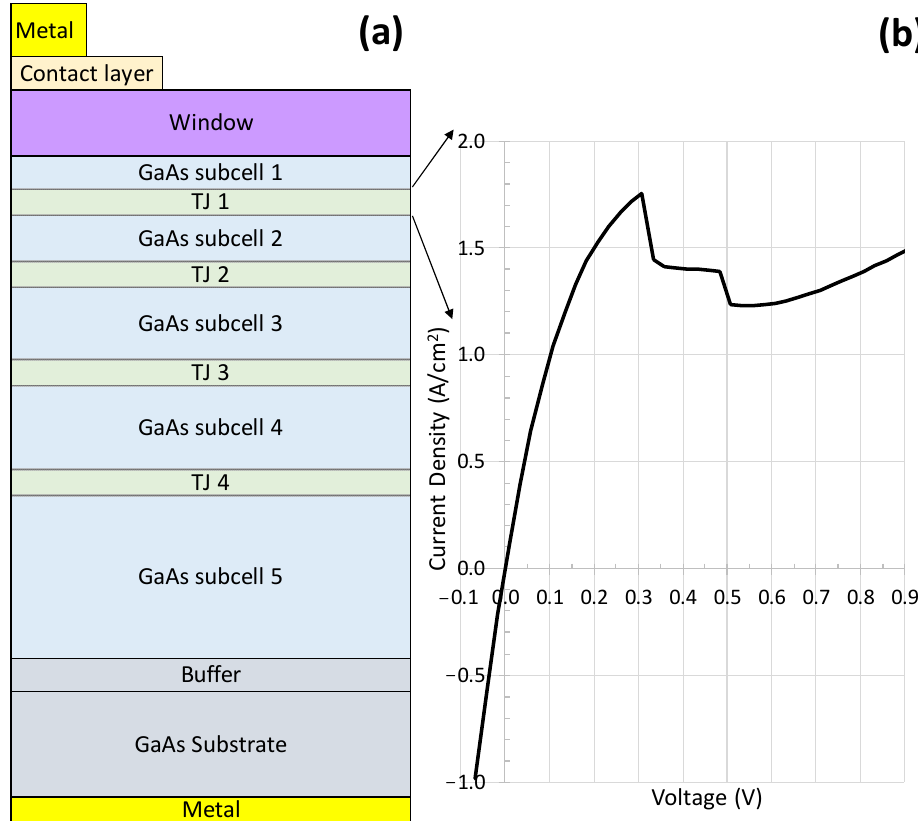
Figure 1. Schematic of the PT5 Vertical Epitaxial HeteroStructure Architecture (VEHSA design) devices prepared with 5 GaAs subcells in ( a ), and average current density vs voltage characteristic of a tunnel junction (TJ) measured from the PT5 structure when the incident optical intensity was high enough to trigger the first TJ negative differential resistance (NDR) behavior in ( b ).